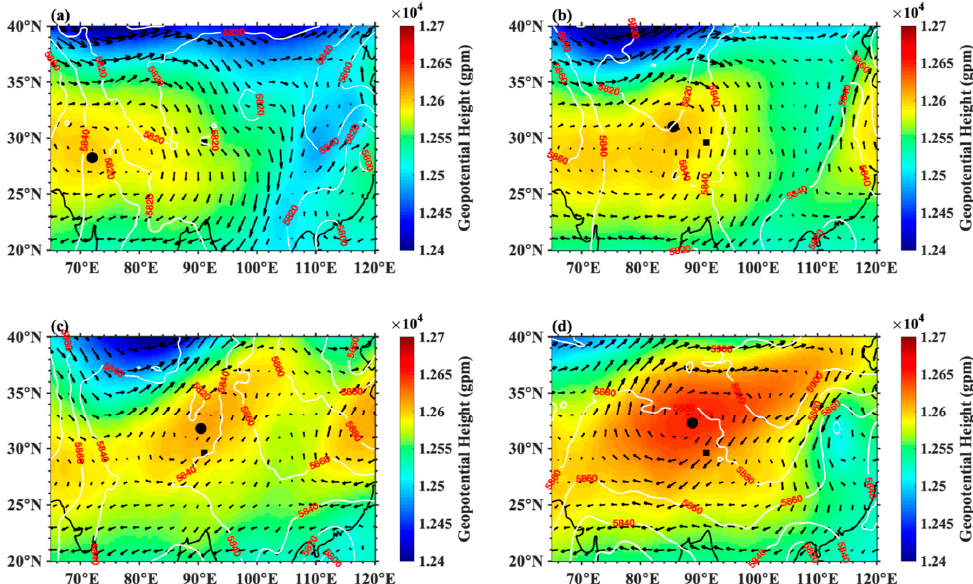
Figure 2. Distribution of the 200 hPa geopotential height (shaded), wind (vector), the 500 hPa geopotential height (contour), and the central region of the ASMA (the black square represents the geographic location of Lhasa, and the black dots represent the strongest negative vortex region. The same symbols are used below). The weather conditions during experimental periods were analyzed using the ERA-interim reanalysis data (http://www.ecmwf.int/, accessed on 17 January 2019) of the European Centre for Medium-Range Weather Forecasts (ECMWF). The horizontal resolutions of the meridional wind and relative vorticity were 2.5° × 2.5° and 0.25° × 0.25°, respectively. ( a ) 12 August 2018; ( b ) 13 August 2018; ( c ) 14 August 2018; and ( d ) 16 August 2018.